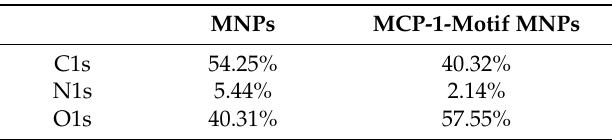
Table 4. Chemical element composition ratio of iron oxide